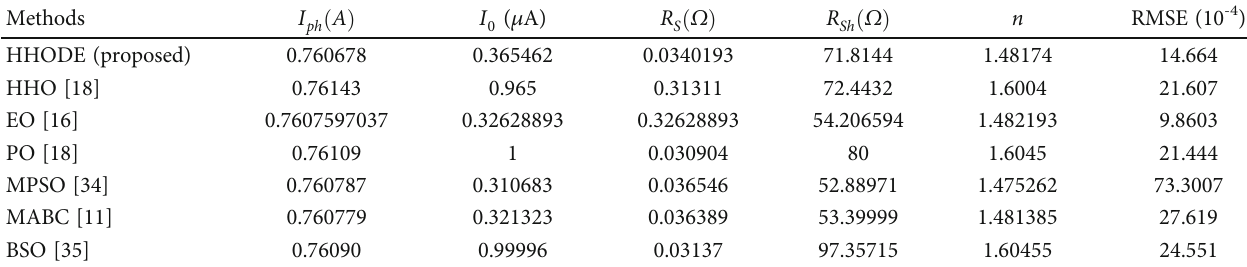
Table 2: Comparison of several methods on the single diode